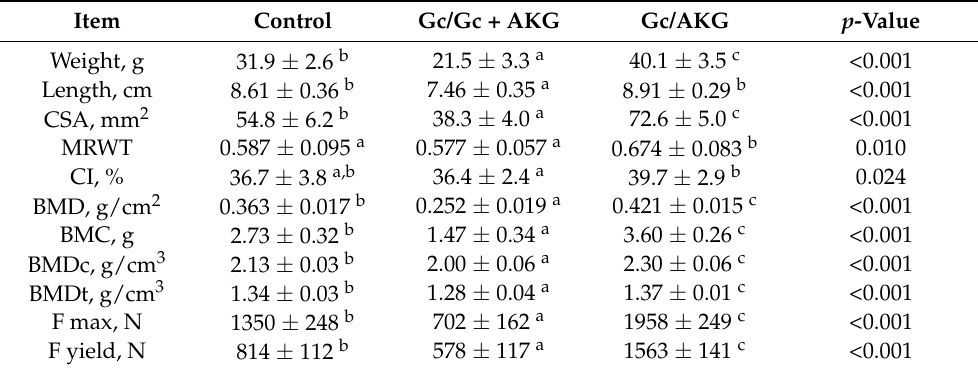
Table 6. Morphology, geometry, density, and mechanical properties of the femur of 35-day-old